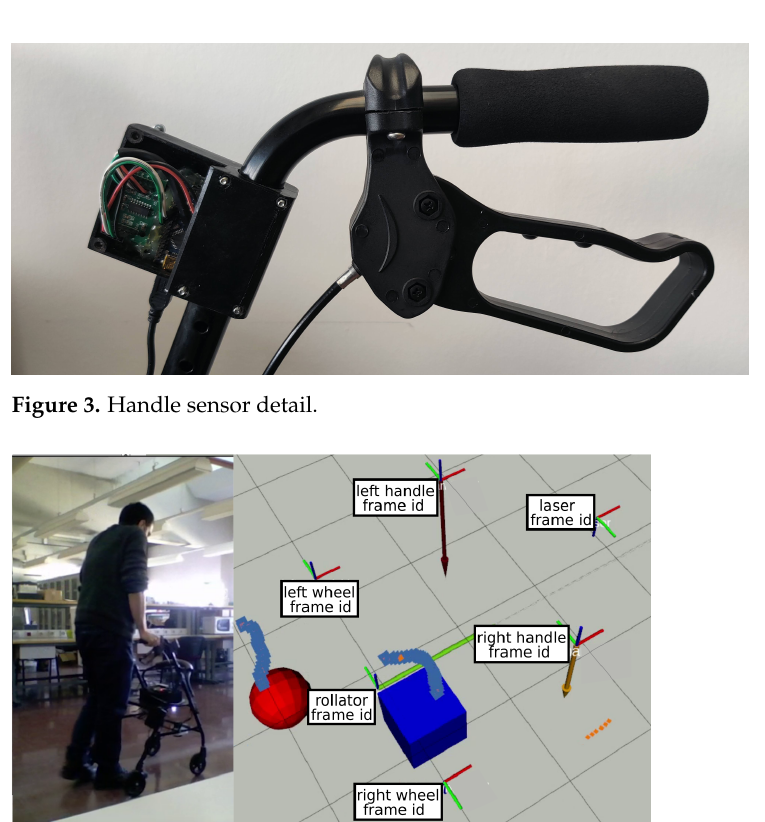
Figure 4. Live data-capture screenshot. Handle forces are displayed as vectors proportional to the load. Odometry is also shown as a green arrow at the middle point between rear wheels.